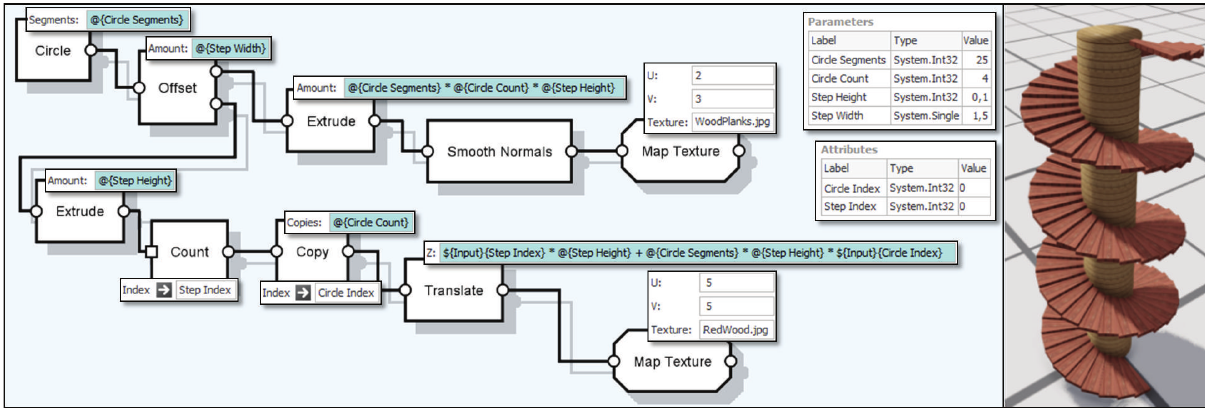
Figure 4: Construction of a stairway using attributes. An offset is applied to a circle to extrude polygonal steps. These are counted and assigned an index attribute. The steps are copied and an additional copy index is assigned. The steps’ translation is steered via these attributes. The boxes above the nodes indicate the assigned fixed values (in white) or expressions (in blue). The notation @{𝑝𝑎𝑟𝑎𝑚𝑒𝑡𝑒𝑟 𝑙𝑎𝑏𝑒𝑙} is used to refer to graph parameters, while $ {𝑝𝑜𝑟𝑡 𝑙𝑎𝑏𝑒𝑙}{𝑎𝑡𝑡𝑟𝑖𝑏𝑢𝑡𝑒 𝑙𝑎𝑏𝑒𝑙} is used to refer to an attribute of an entity coming from a certain node port. The boxes with arrows under the nodes indicate attribute